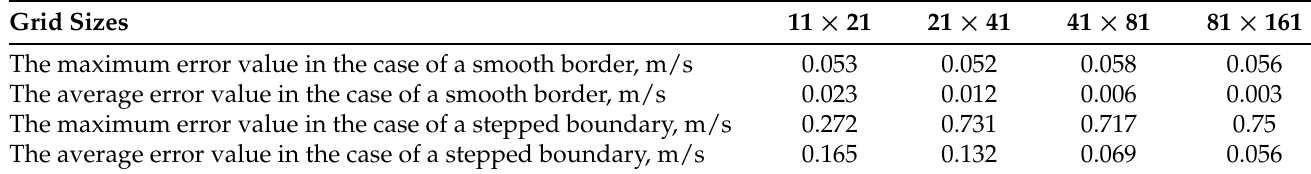
Table 2. Dependence of the approximation error values on the computational grid size.